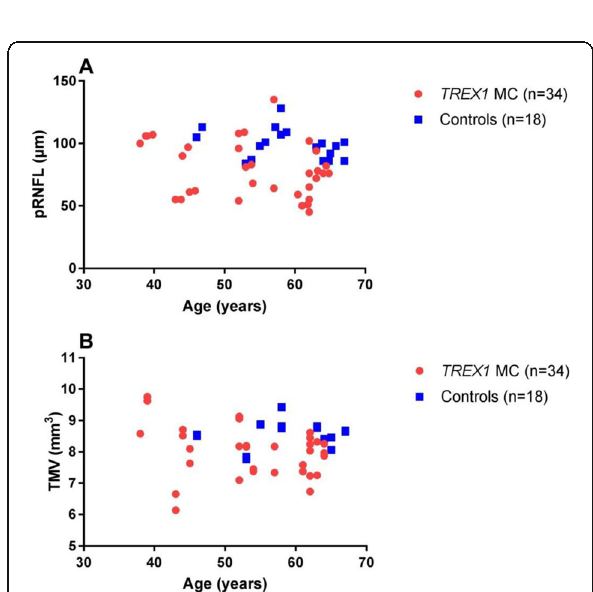
Fig. 2 (abstract P75). Distribution of peripapillary retinal nerve fiber layer thickness (A) and total macular volume (B) with age in TREX1 mutation carriers and controls. Mutation carriers (MC); Peripapillary retinal nerve fiber layer (pRNFL); total macular volume